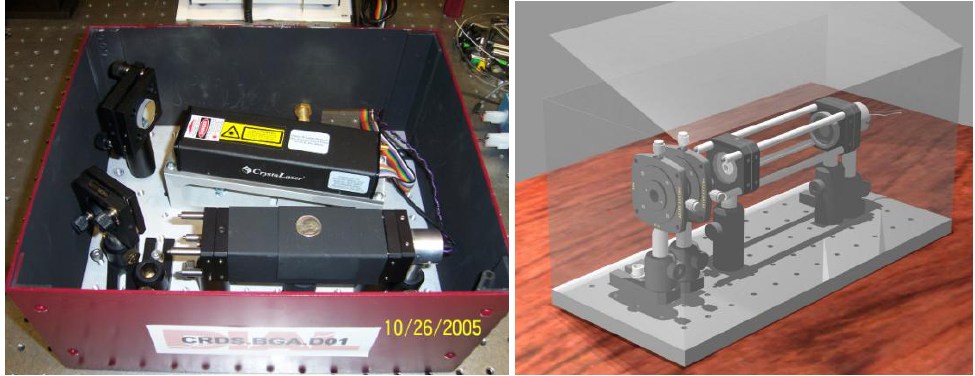
Figure 5. A prototype acetone breath analyzer using pulsed-CRDS at 266 nm. Left: The instrumental package; right: Detailed pictorial view of the optical cavity